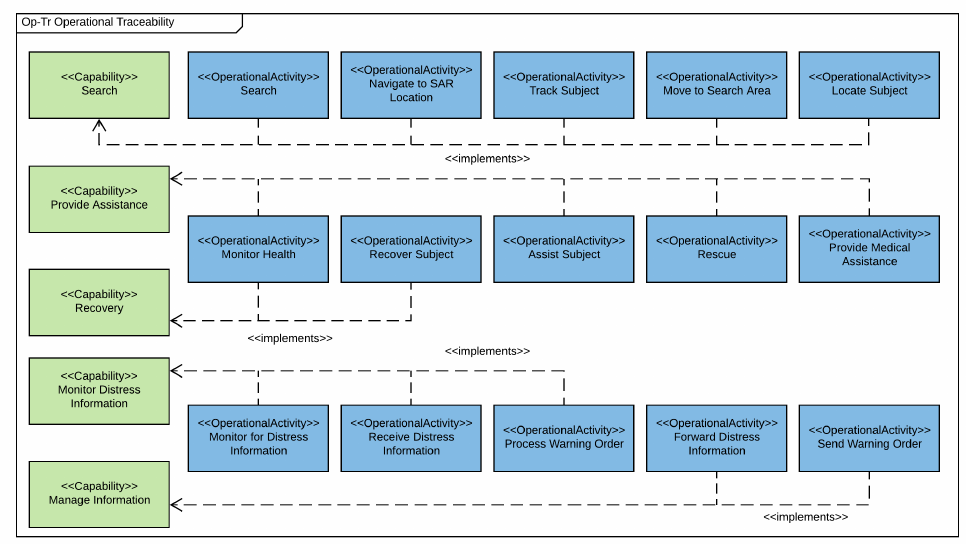
Figure 8. An example of an Operational Traceability (Op-Tr) view of the UAF that describes the con- nection between capabilities and operational activities.